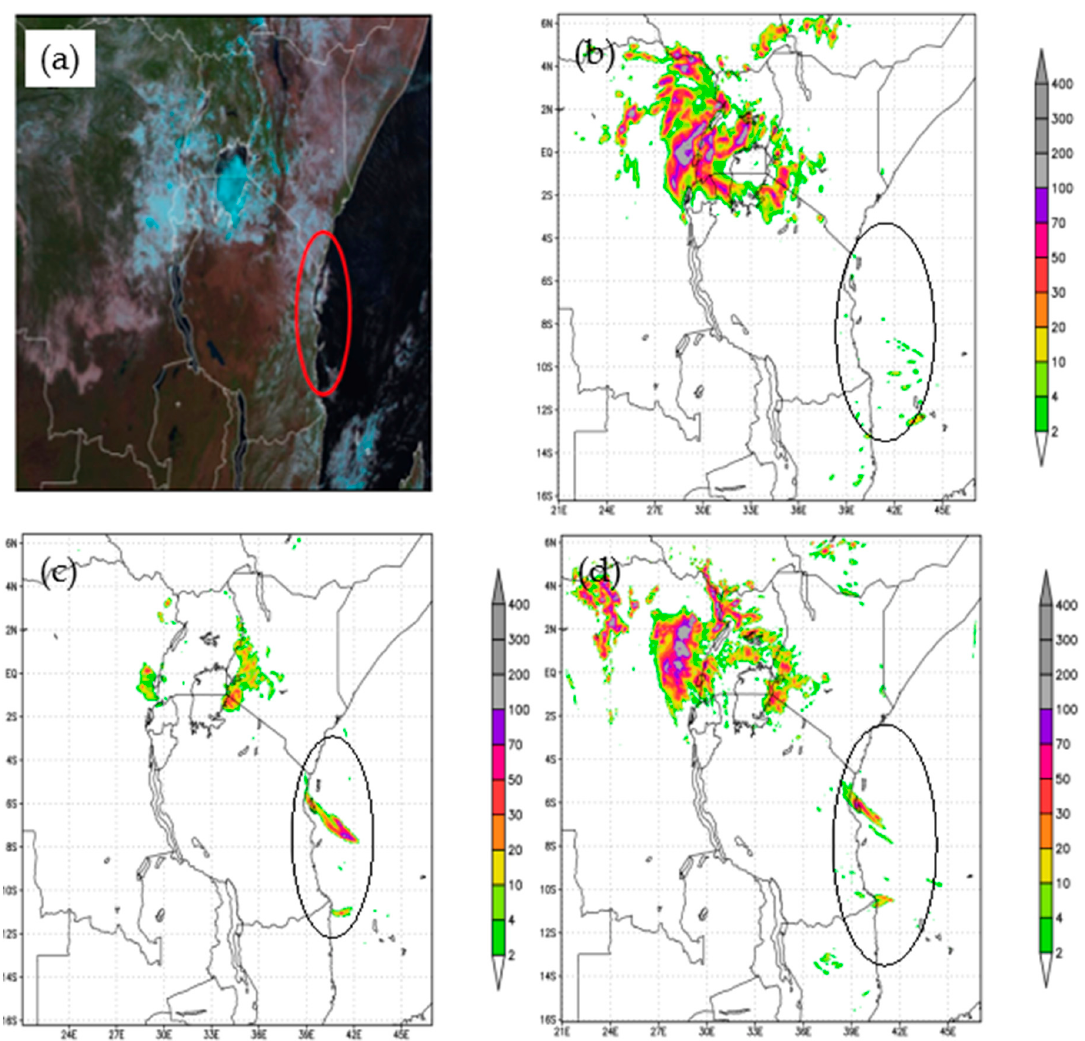
Figure 9. Total precipitation amount for the dry season on 26 July 2014. ( a ) Day natural color RGB VIS0.6 VIS0.8 NIR1.6 satellite observation at 1015UTC (image source: EUMETSAT); and 24-h accumulated model rainfall forecasts for ( b ) 15 / 5 km resolution; ( c ) 12 / 4 km resolution; ( d ) 9 / 3 km resolution. The colorbar represents the total precipitation amount (mm).